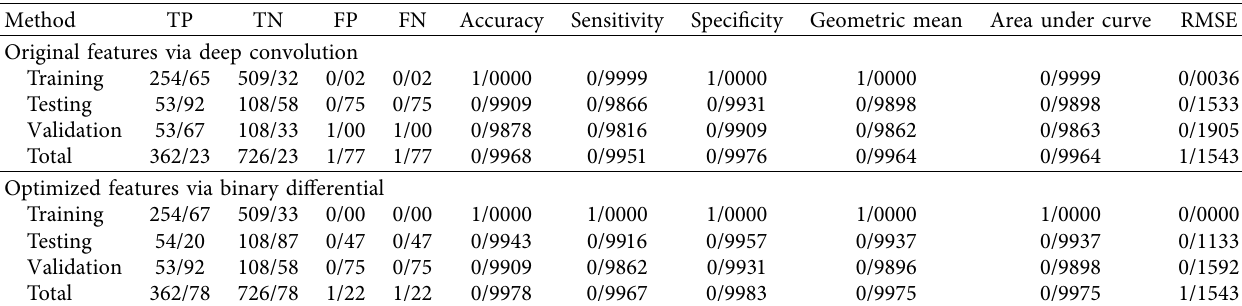
Table 3: Average of the confusion matrix components after 100 runs using original and optimized